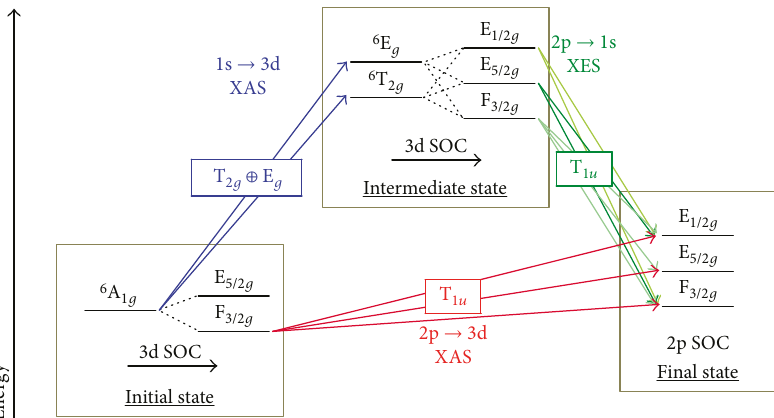
Figure 39: Multielectronic term scheme for Fe 3+ 3d 5 high spin comparing the1s2p RIXS and direct 2p XAS pathways. Where SOC is included ( S = 5/2 ), the spin multiplicity is